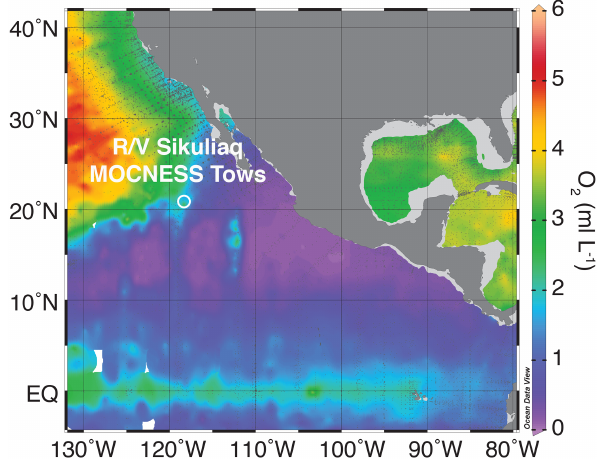
Figure 1. Location of MOCNESS tows (white circle) taken on board the R/V Sikuliaq plotted against a map of dissolved oxygen at 200m below the sea surface. Oxygen data are aggregated from the World Ocean Atlas (Garcia et al., 2018) and plotted using Ocean Data Viewer.